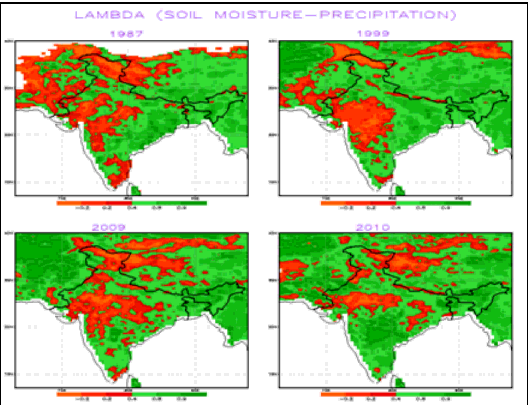
Figure 9. Soil moisture precipitation feedback λ NC (SM, P) using CLM scheme for El Niño (1987,2009), La Niña (1999,2010)